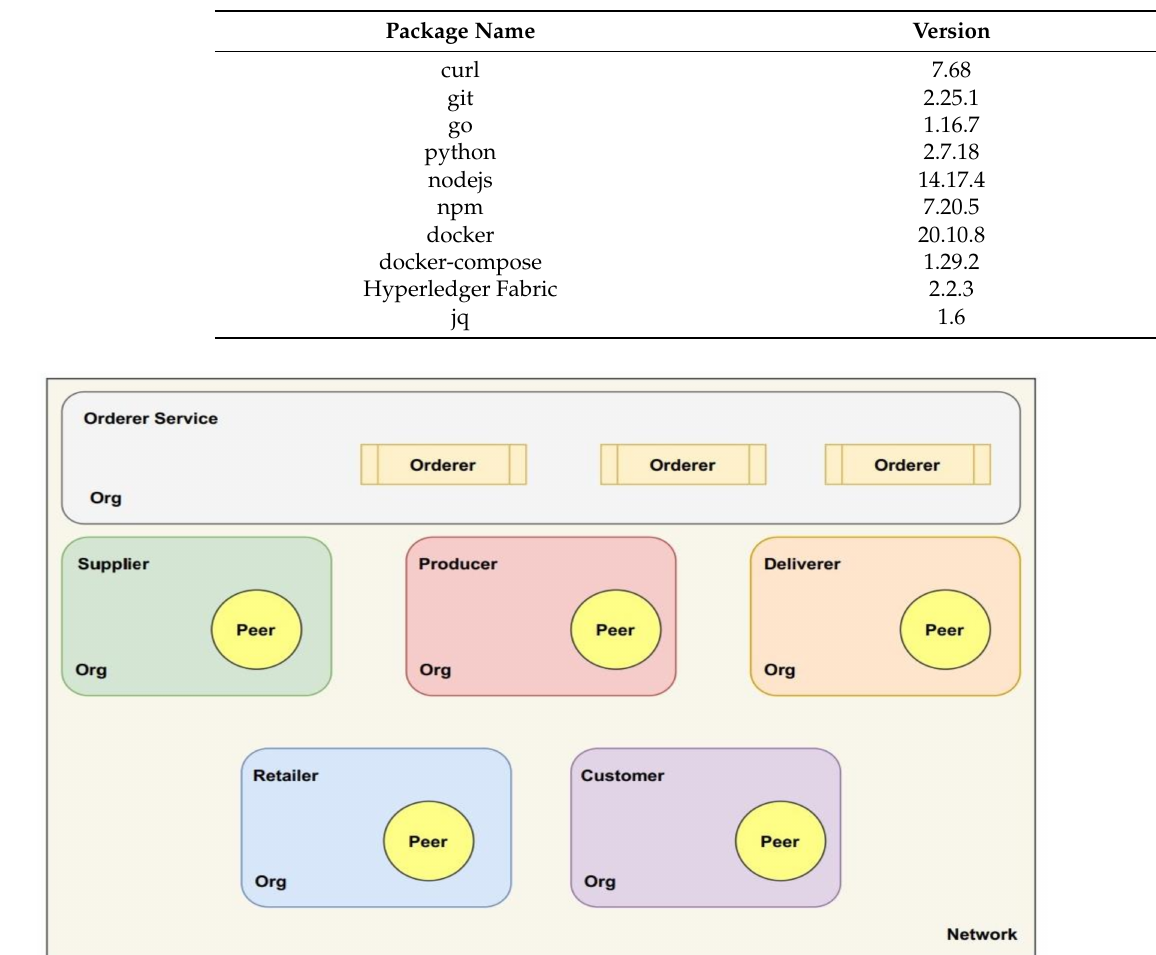
Figure 10. Parties in the developed